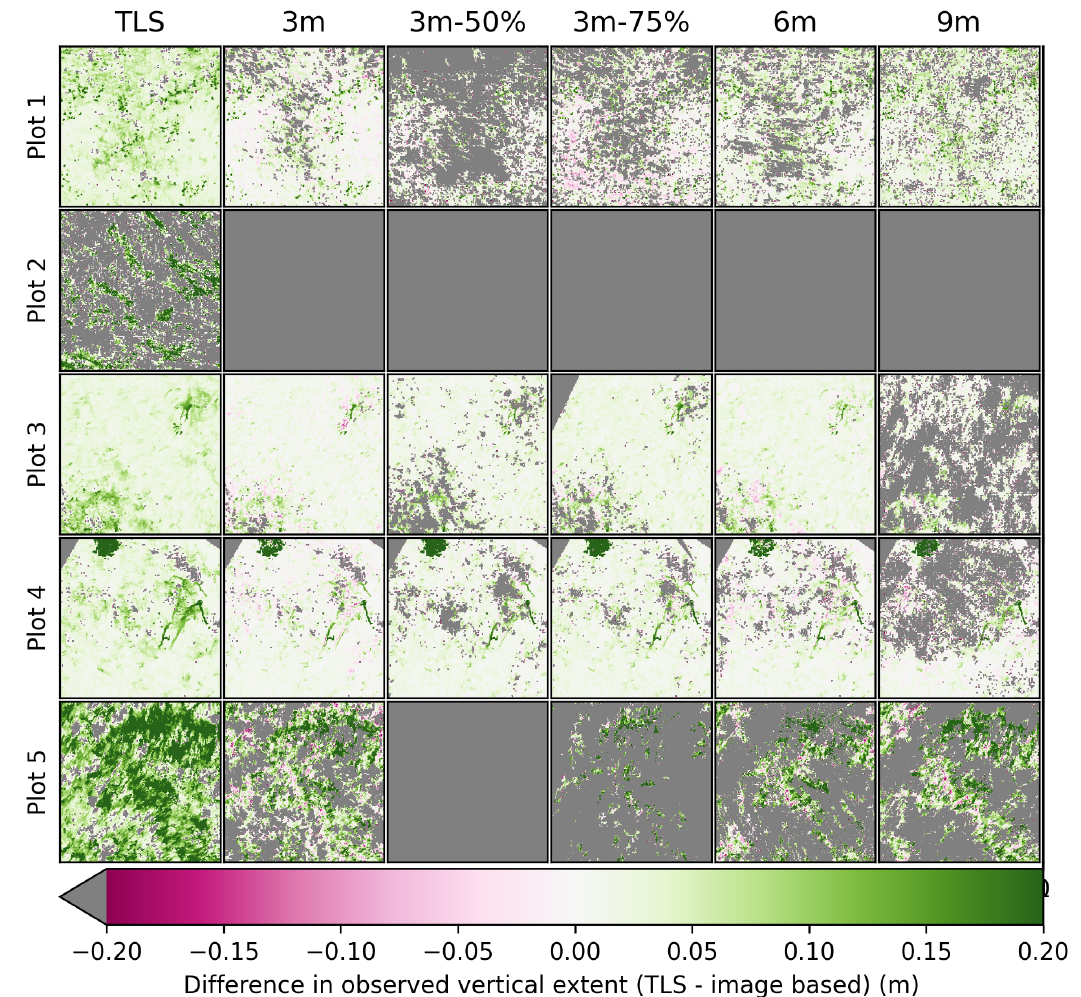
Figure 5. Differences between the vertical extent ( 5th–95th percentile) observed between the TLS and each representation produced using the image-based